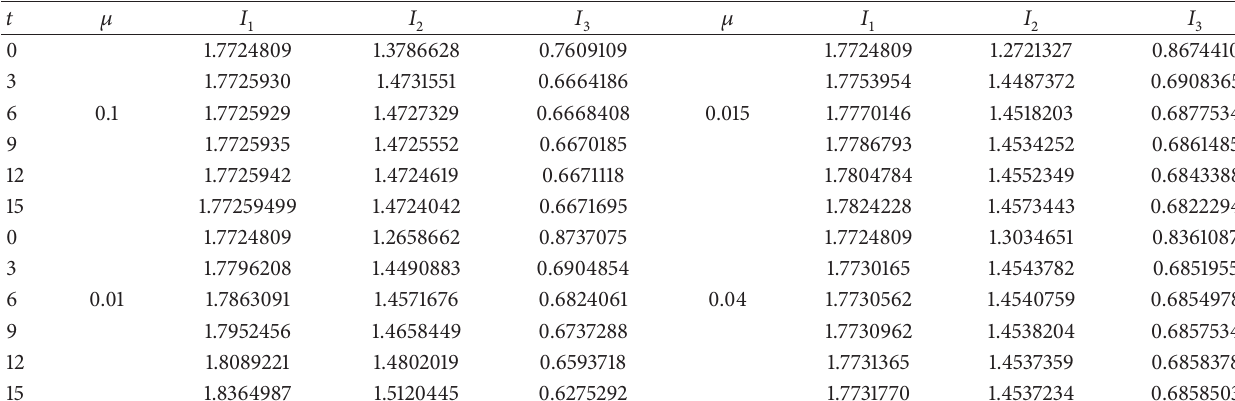
Table 8: Invariants of MRLW equation using the Maxwellian initial